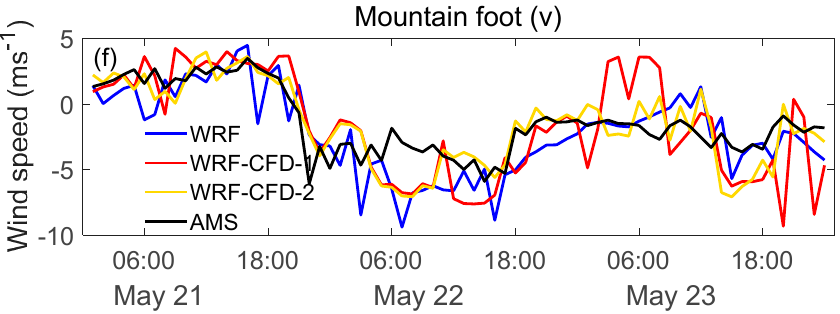
Figure 10. Time series of predicted wind speed using different models: WRF, WRF ‐ CFD ‐ 1, and WRF ‐ CFD ‐ 2: ( a – b ) mountaintop; ( c – d ) mountainside; ( e – f ) mountain foot.